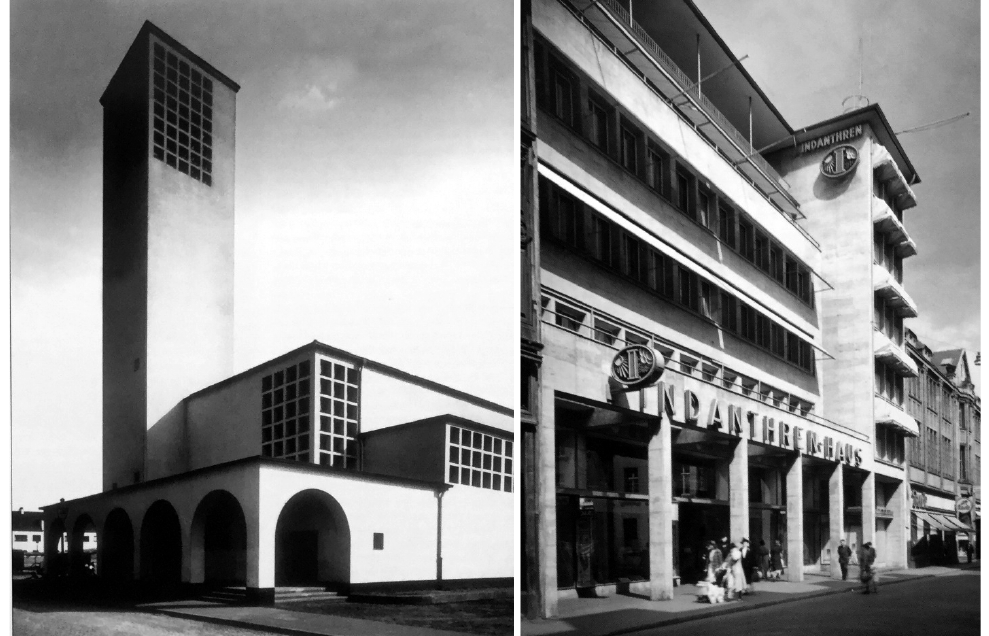
Figure 18. From left to right: W. Riphahn, Cologne-Buchforst, Weisse Stadt . Church of St. Peter Canisius (1929–1930). View from southwest (Mantz, 1931); W. Riphahn, Office and commercial building ‘Indanthren’. General view from Breite Strasse, Cologne 1939 (Mantz,